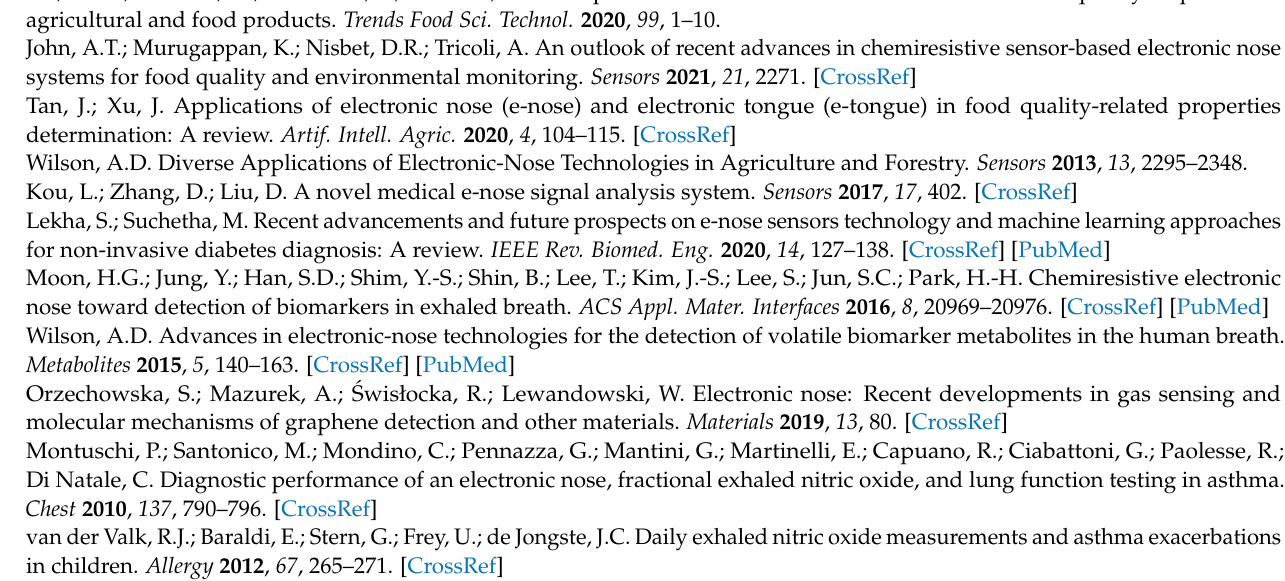
Table S3: Comparative Analysis of MR Fitting